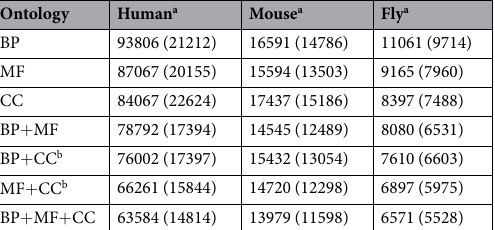
Table 1. Number of annotated proteins in the organism data sets. a Numbers refer to IEA ( + ) data sets, whereas numbers in parentheses refer to IEA ( − ) data sets. b Available on the Frela web server, but not further discussed in this